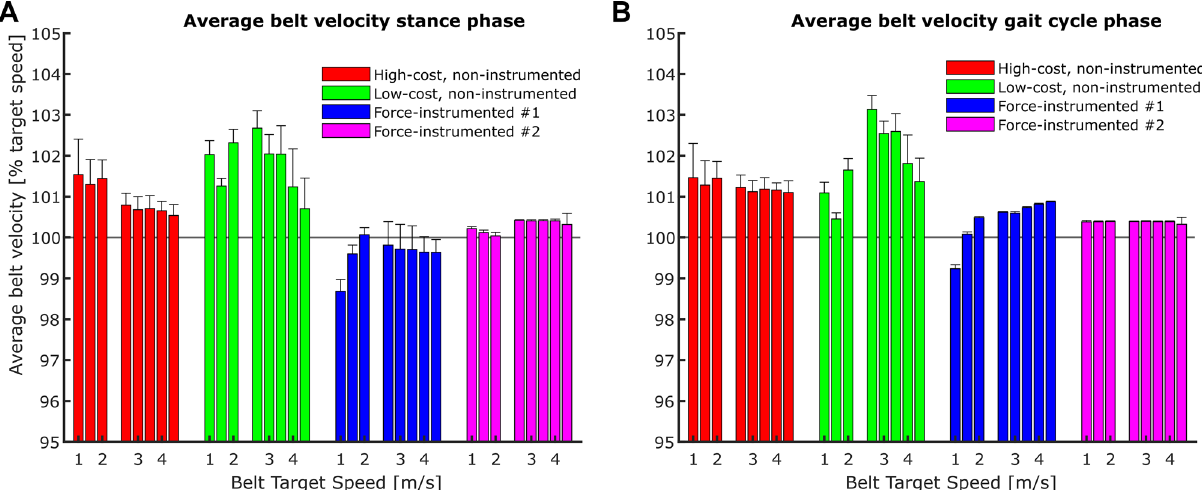
Figure 4. Average treadmill belt velocity (mean ± standard deviation) quantified for the stance phase ( A ) and the entire gait cycle ( B ) for four treadmills at different locomotion speeds. We separated the bars of the walking speeds (1.0 m/s to 2.0 m/s) from the bars of the running speeds (2.5 m/s to 4.5 m/s).